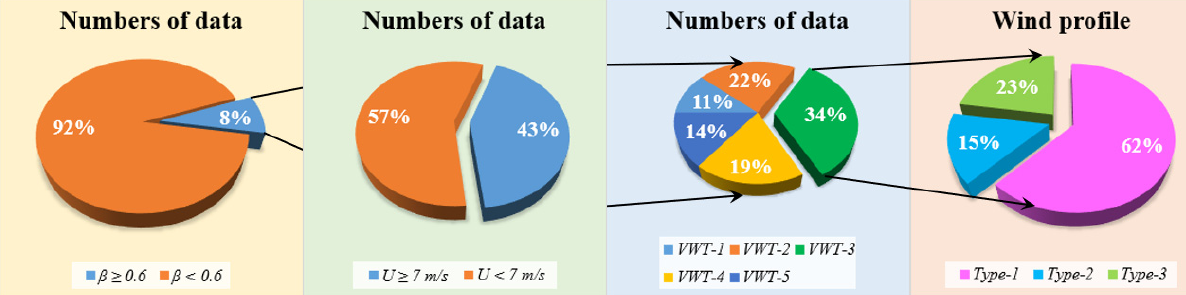
Figure 9. Flow chart of the raw data selection.